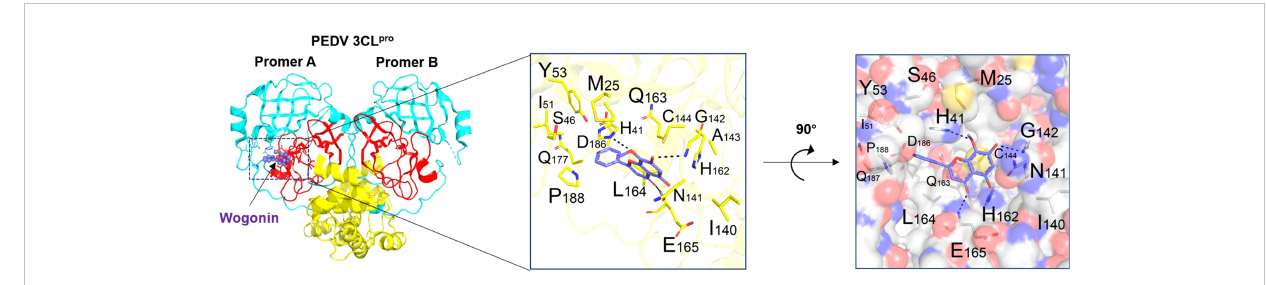
FIGURE 4 Binding mode analysis of wogonin and Mpro. Two perpendicular views are shown. Mpro is indicated as ribbon (yellow) and cylinder (denotes residues, green). Wogonin is shown in ball-and-stick models (purple). Protomer A (catalytically competent enzyme) is presented on the left and protomer B (inactive enzyme) is shown on the right. Domain I (residues 8 − 101), domain II (residues 102 − 184), and domain III (residues 201 − 306) can be seen.